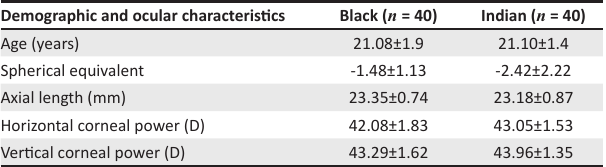
TABLE 1: Means and standard deviations for demographic and ocular characteristics of the black ( n = 40) and Indian ( n = 40) ethnic groups. Demographic and ocular